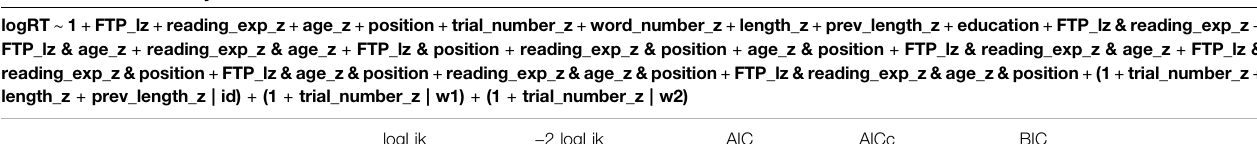
TABLE 2 | Model output, linear mixed effects model with forward transition probability. Linear mixed model fi t by maximum